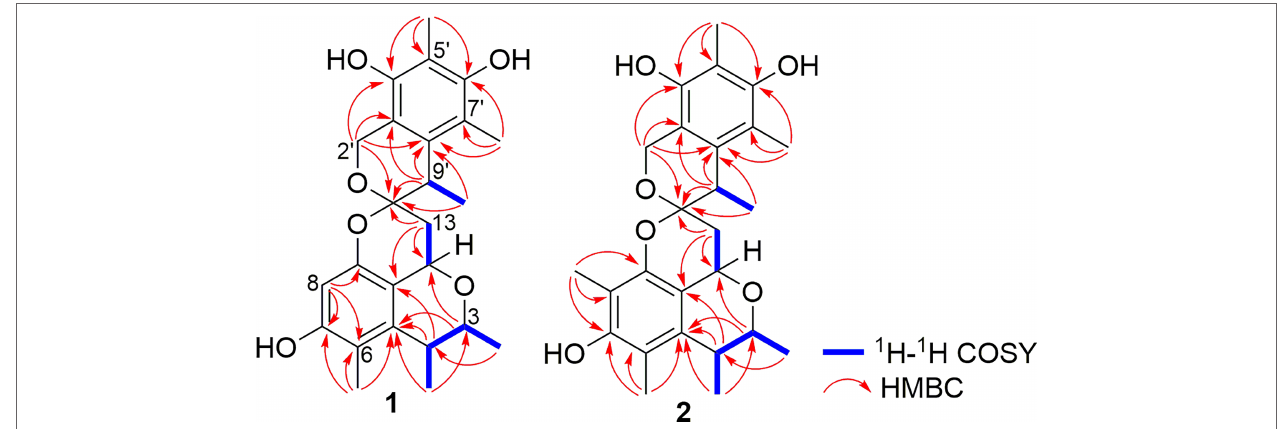
FIGURE 2 | Key 1 H- 1 H COSY and HMBC correlations of compounds 1 and